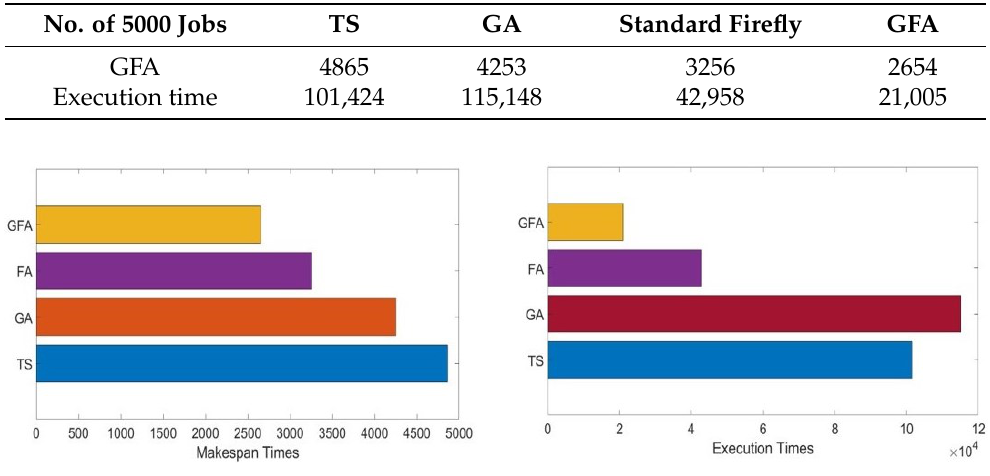
Figure 9. Makespan and Execution times for Typical Workloads.